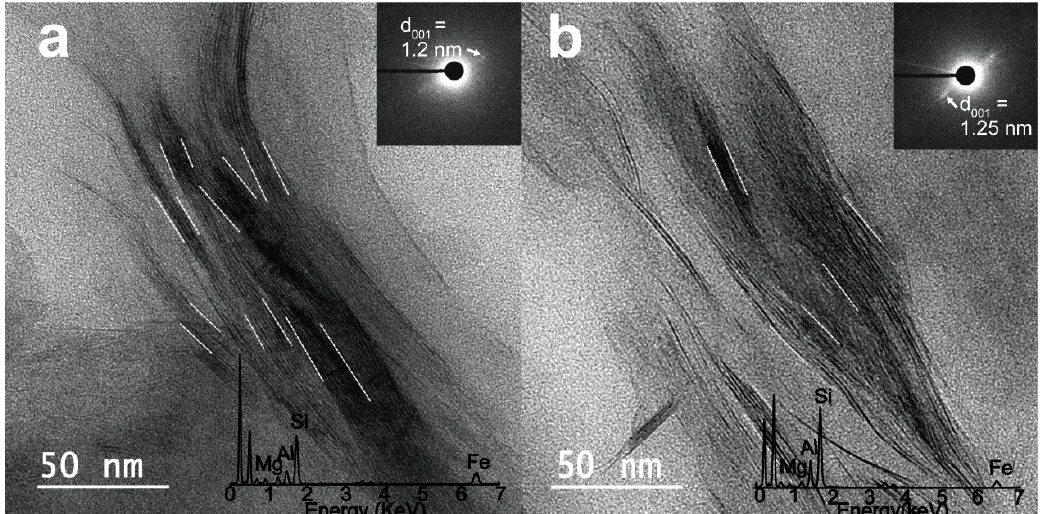
Figure 4. Representative TEM micrographs of lattice fringes in smectites from core GC05-DP02 from ( a ) a glacial MIS 10 (with an inset figure of the selected-area electron diffraction (SAED) pattern of smectite (d 001 = 1.2 nm)) and ( b ) an interglacial MIS 9 (with an inset figure of the SAED pattern of smectite (d 001 = 1.25 nm)). The elemental composition of smectite was obtained using TEM-energy dispersive X-ray spectrometer (TEM-EDS).